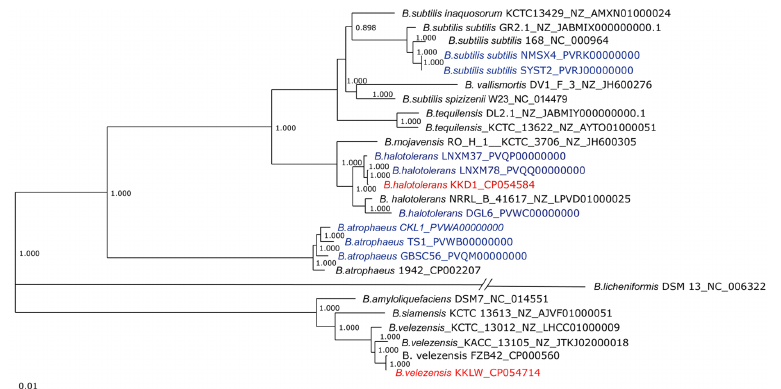
Figure 4. Phylogenetic tree. Phylogenetic tree for 26 genomes constructed from a core of 1743 genes per genome (45,318 in total). The core has 519,198 AA-residues/bp per genome and 13,499,148 in total. B. halotolerans KKD1 is labelled by red letters. Strains previously isolated from the Qinghai–Tibetan plateau are labelled by blue letters. B. licheniformis DSM13 was used as an outgroup. FastTree software was implemented with the EDGAR package to generate an approximately-maximum-likelihood phylogenetic tree. The values at the branches of the FastTree trees are not bootstrapped values but are local support values computed by FastTree using the Shimodaira-Hasegawa test (FastTree, http://www.microbesonline.org/fasttree/; accessed on 04 October 2021).